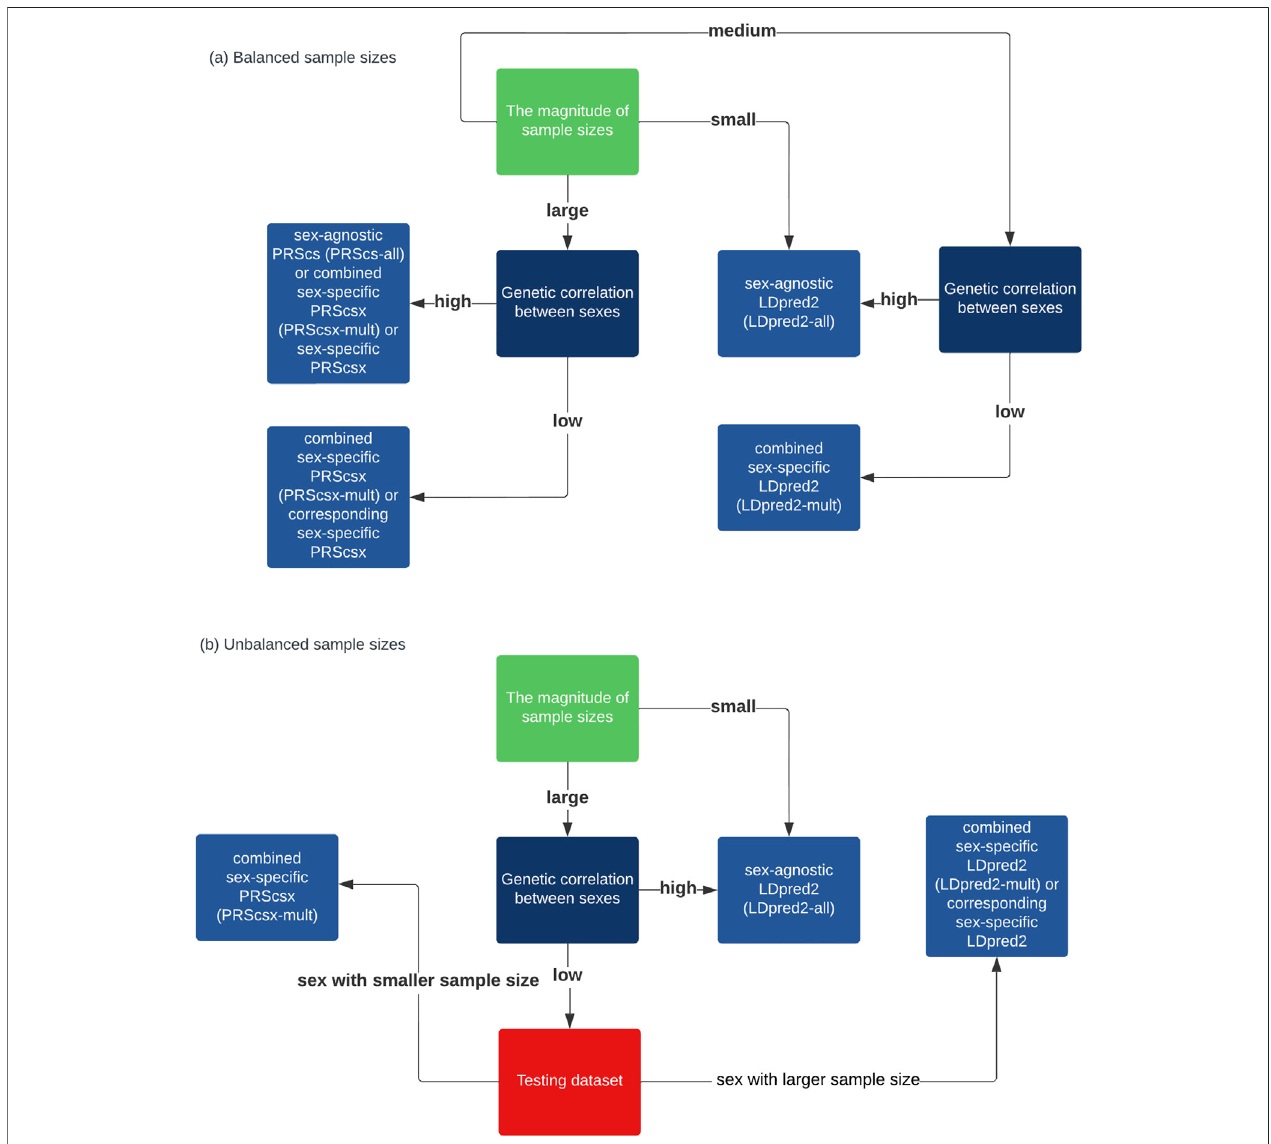
FIGURE 3 | Flow charts that provide a synthesized guide for practitioners to choose among these methods. (A) When the sample sizes are balanced between sexes. (B) When the sample sizes are unbalanced between sexes.